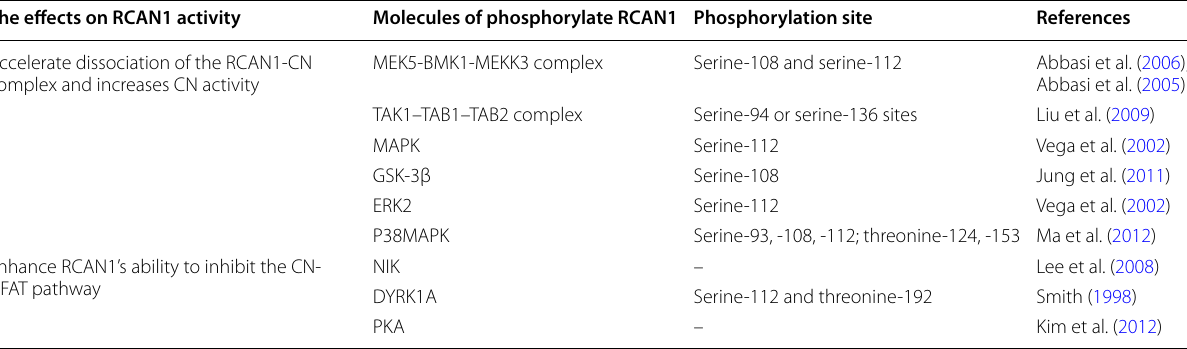
Table 1 The molecules of phosphorylated